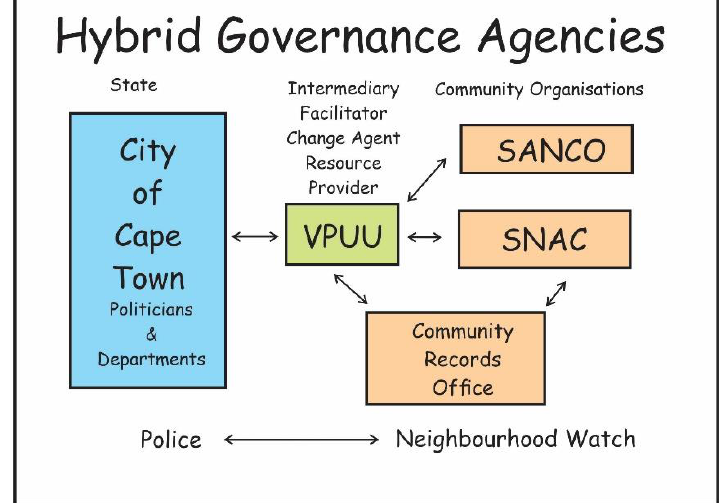
Figure 1. Hybrid Governance Arrangements in Monwabisi Park.